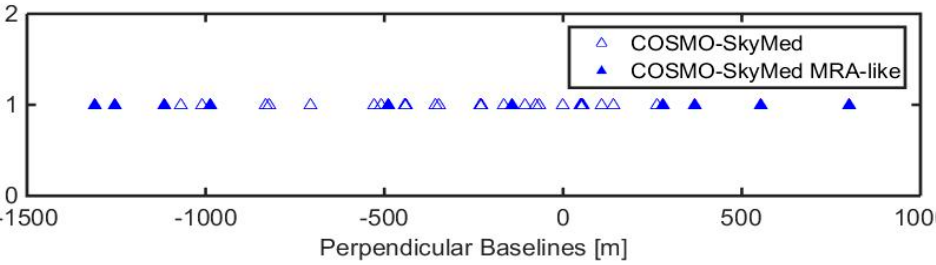
Figure 9, with perpendicular baseline apertures of approximately 2110.5 m (COSMO-SkyMed) and 527.5 m (TerraSAR-X/TanDEM-X), respectively.